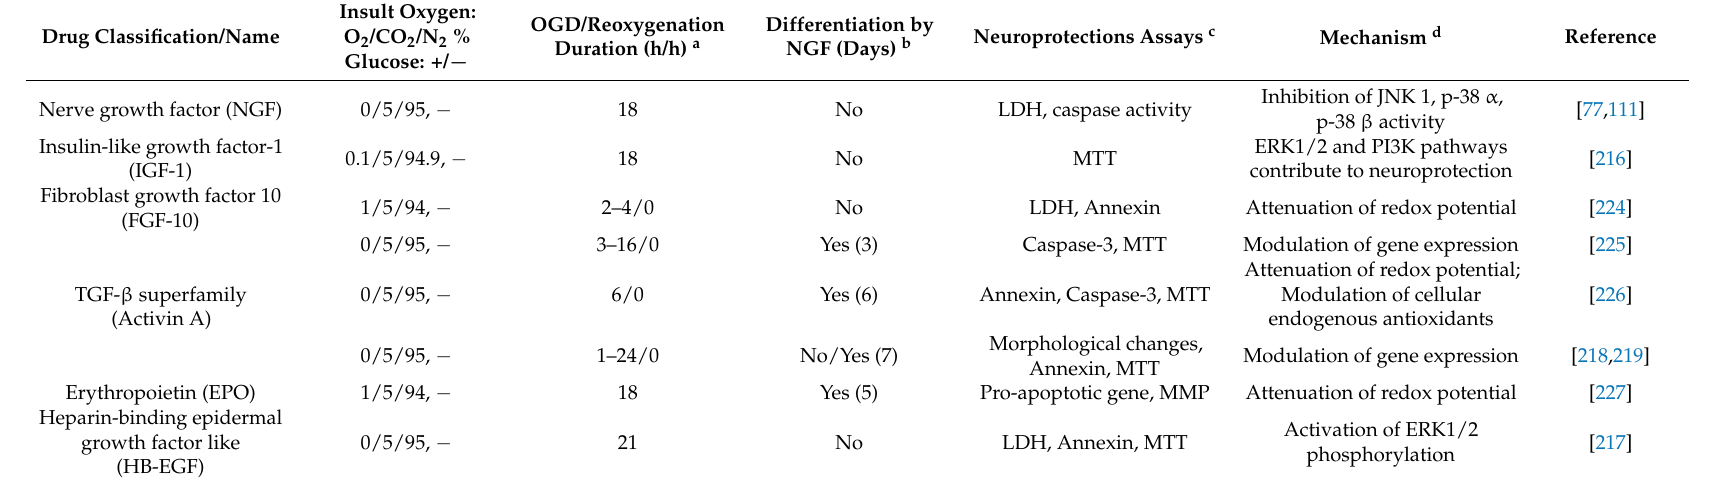
Table 3. Neuroprotective effect and proposed mechanism of different growth factors using PC12 OGD/R